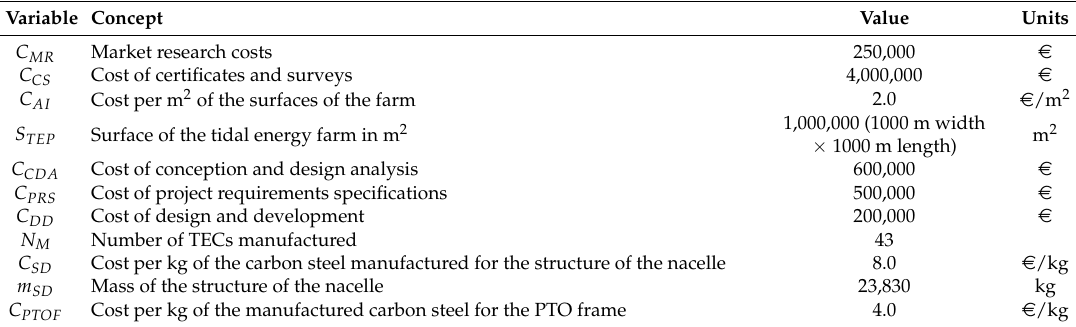
Table A1. Values of the variables in the case